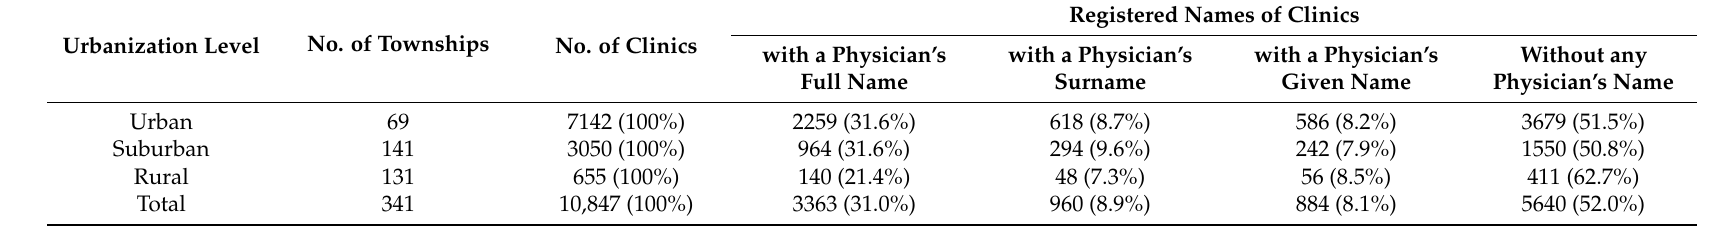
Table 1. Registered names of private physician clinics at different urbanization levels in